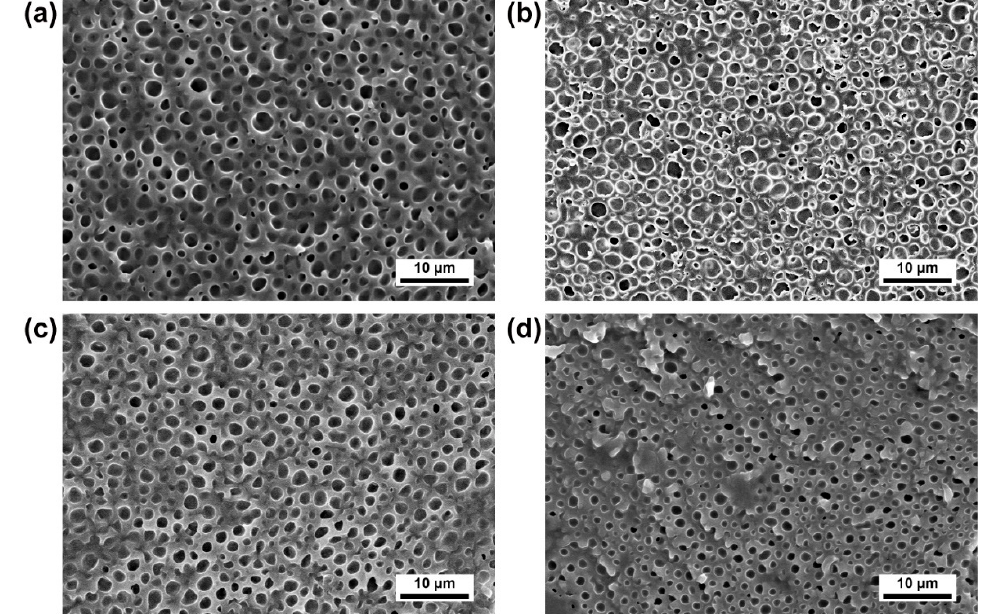
Figure 7. The polymer morphologies of samples C1–C4: ( a ) Sample C1; ( b ) Sample C2; ( c ) Sample C3; ( d ) Sample C4.